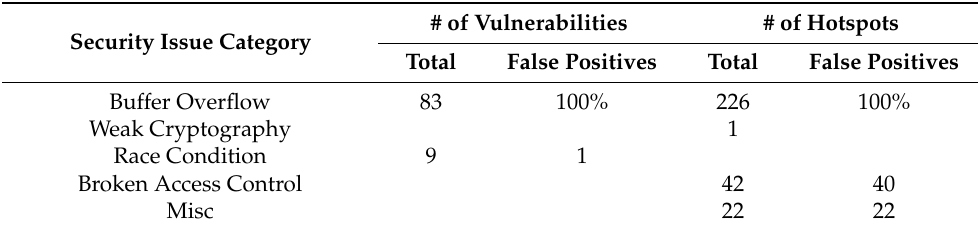
Table 18. Number of security issues of different categories in